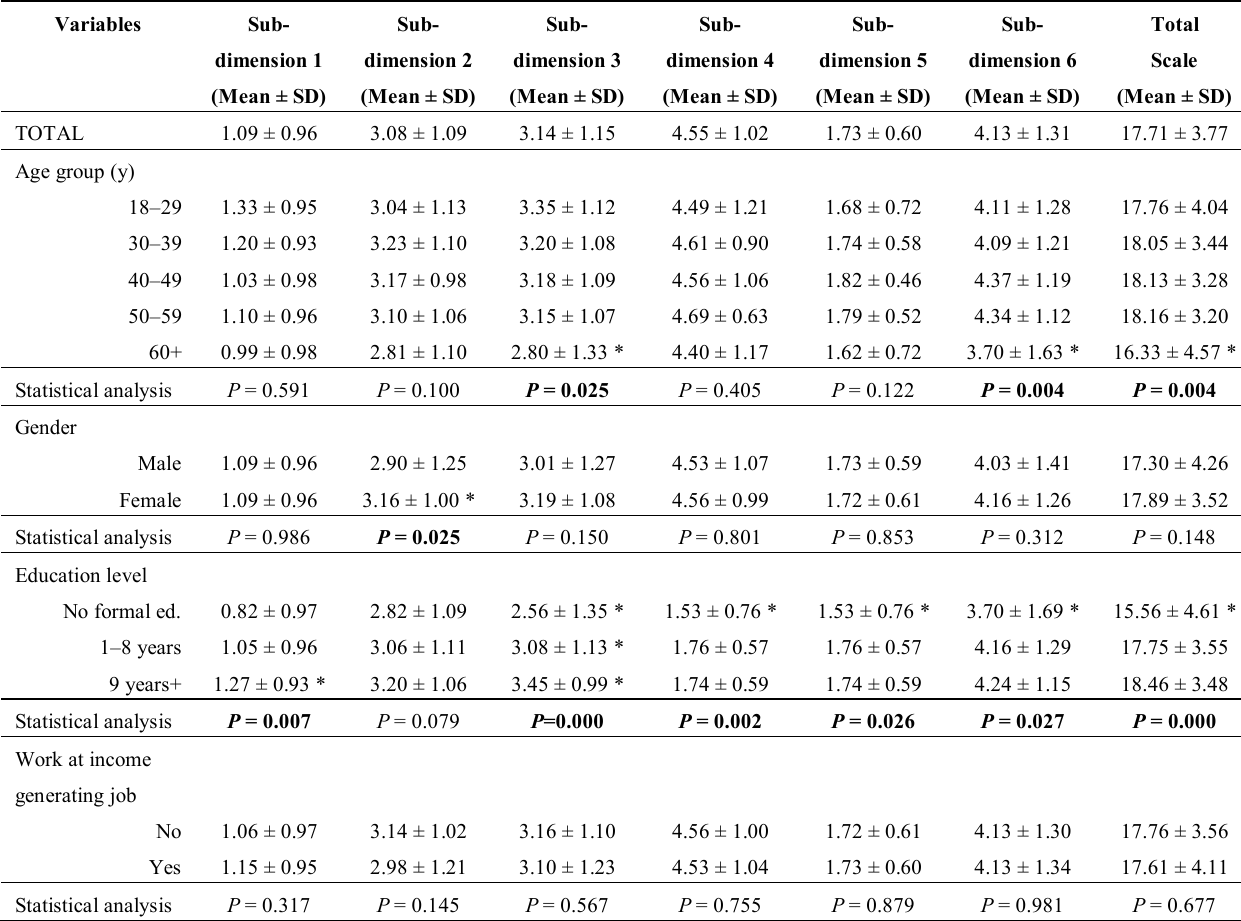
Table 3. The distribution of sub-dimensions and total HK-LS scale according to various demographic characteristics of the study